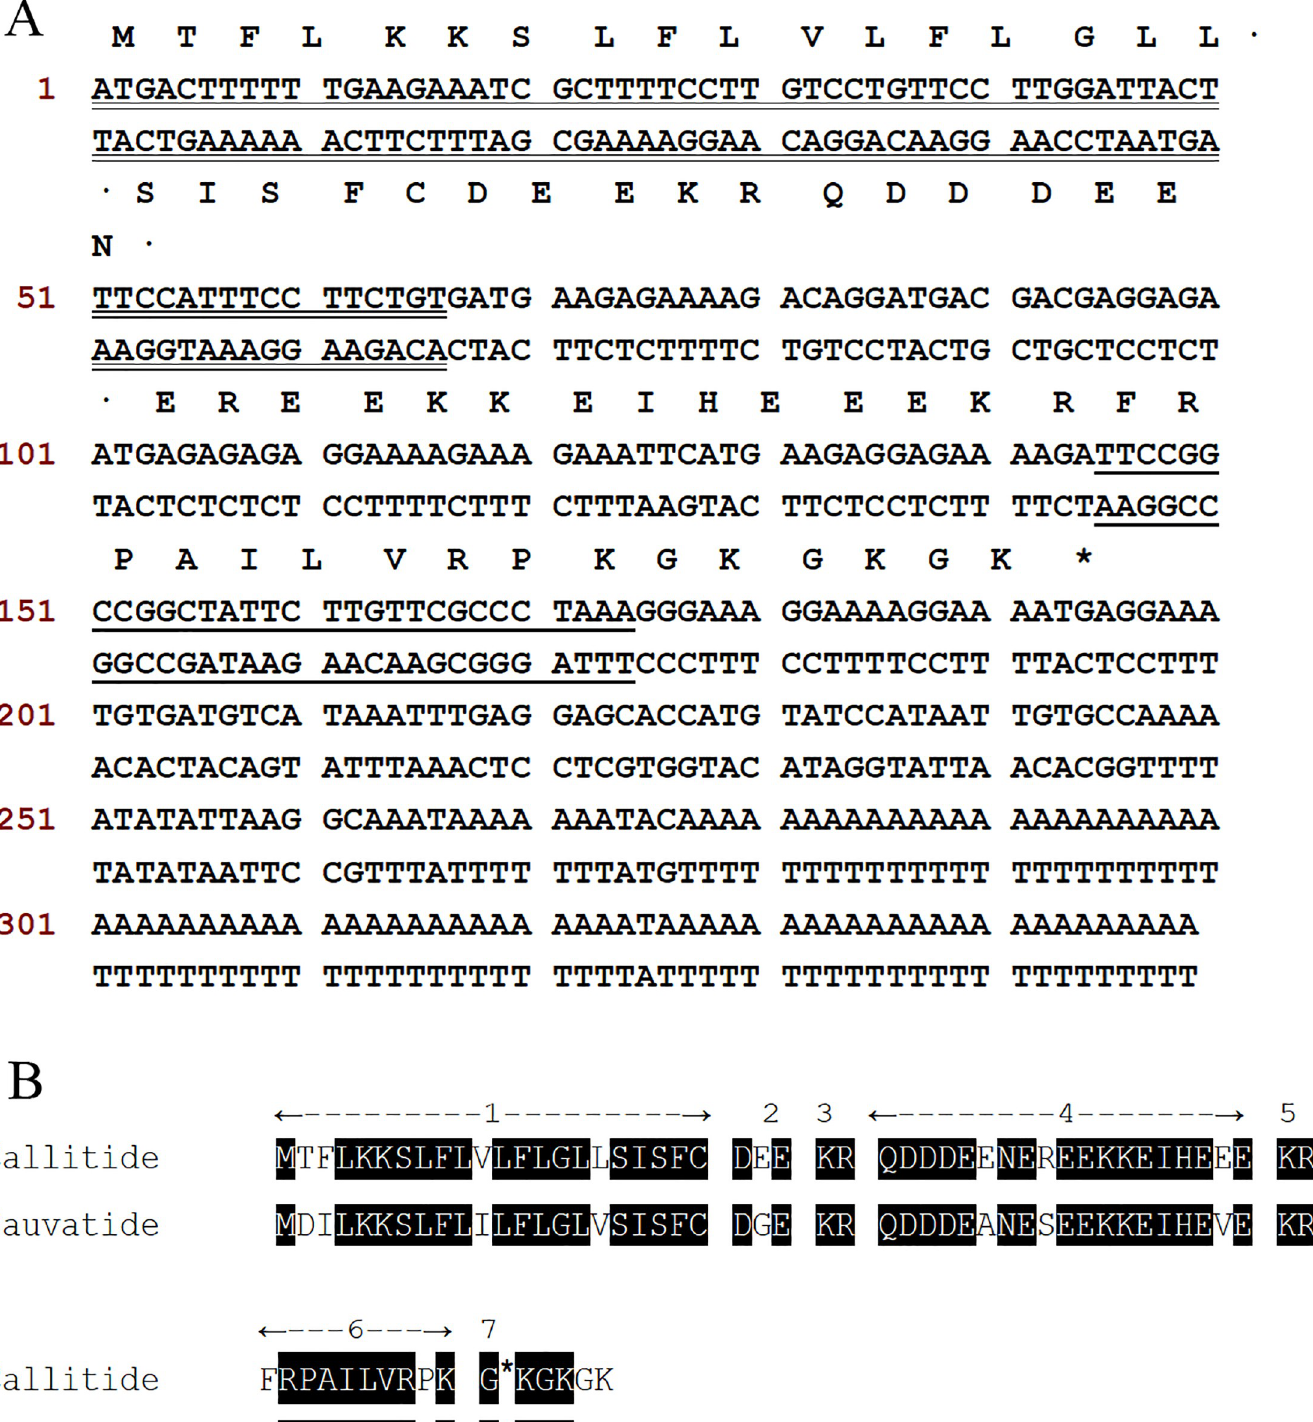
PLOS ONE | https://doi.org/10.1371/journal.pone.0243326 December3, 2020 5 /